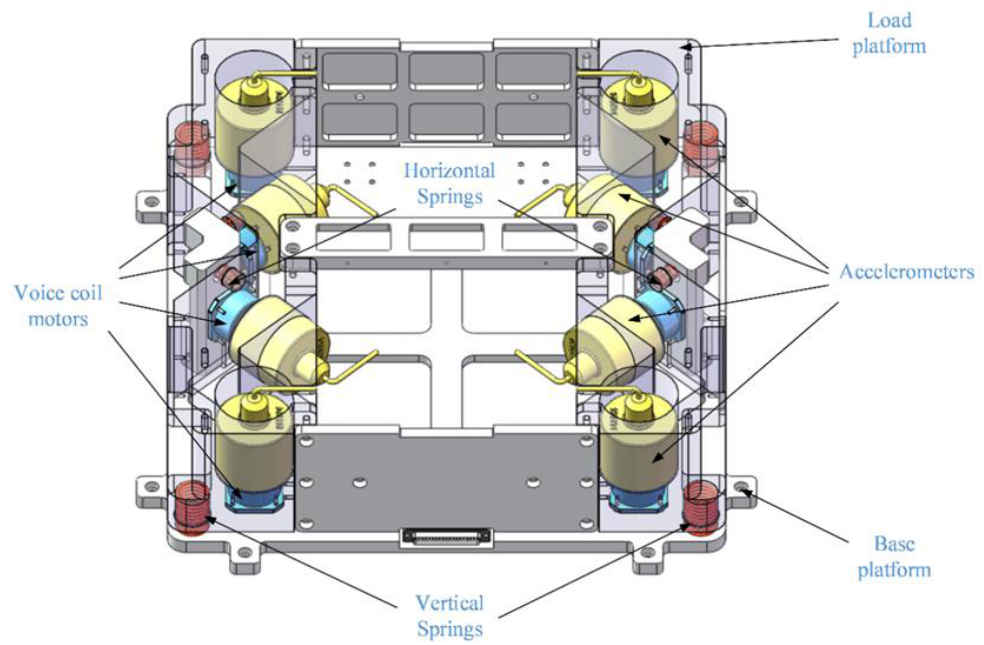
Figure 1. Structure of active vibration isolation system.